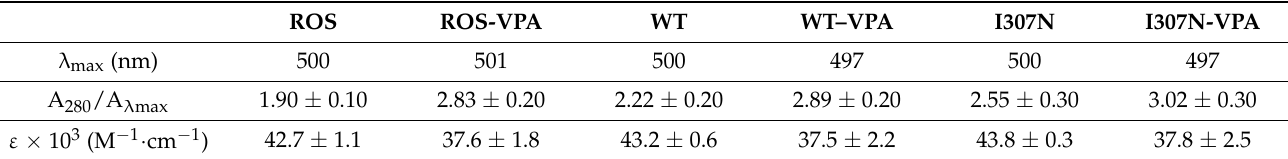
Table 1. UV-Vis Spectroscopy: UV-vis spectral parameters of ROS, WT, and I307N mutant Rhos, with and without VPA treatment, in the dark state. ROS ROS-VPA WT WT–VPA I307N